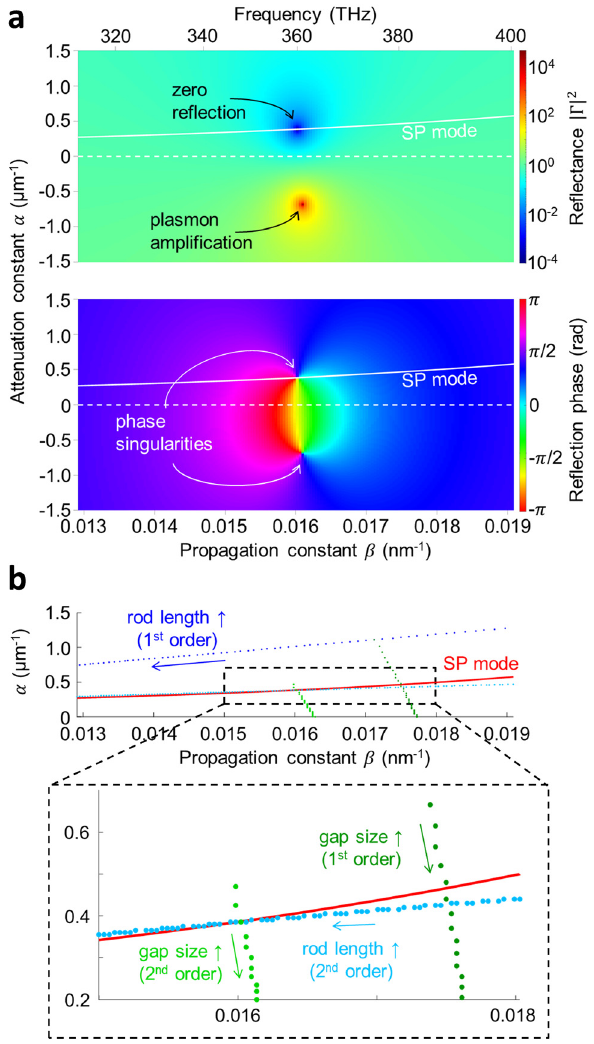
Figure 3: (a) The reflectance (upper panel) and reflection phase (lower panel) plotted over the complex wavevector plane for a specific terminal condition (rod length = 346 nm, gap = 4 nm), at which one of the phase singularities hits the dispersion curve of the guided mode, leading to zero re fl ection for one speci fi c value of β . β and α are the real and imaginary parts of the wavevector. Negative α representsgain. (b)Upperpanel: trajectories of the re fl ectionphase singularities of the fi rst-order and second-order nanorods reso- nance upon sweeping the gap size (increment 0.5 nm per dot) and nanorod length (increment 1 nm). Dark blue and dark green dots mark the trajectories of the phase singularity of the fi rst-order resonance upon increasing the rod length (126 – 187 nm) and gap size (4 – 19 nm), respectively. Light blue and light green dots mark the trajectories of the phase singularity of the second-order reso- nance upon sweeping the rod length (290 – 431 nm) and gap size (3 – 20nm),respectively.Theredsolidcurvedepictstheallowed α and β for the TM 0 mode on the nanowire. Lower panel: enlarged plot cor- responding to the area marked by the dashed rectanglein the upper